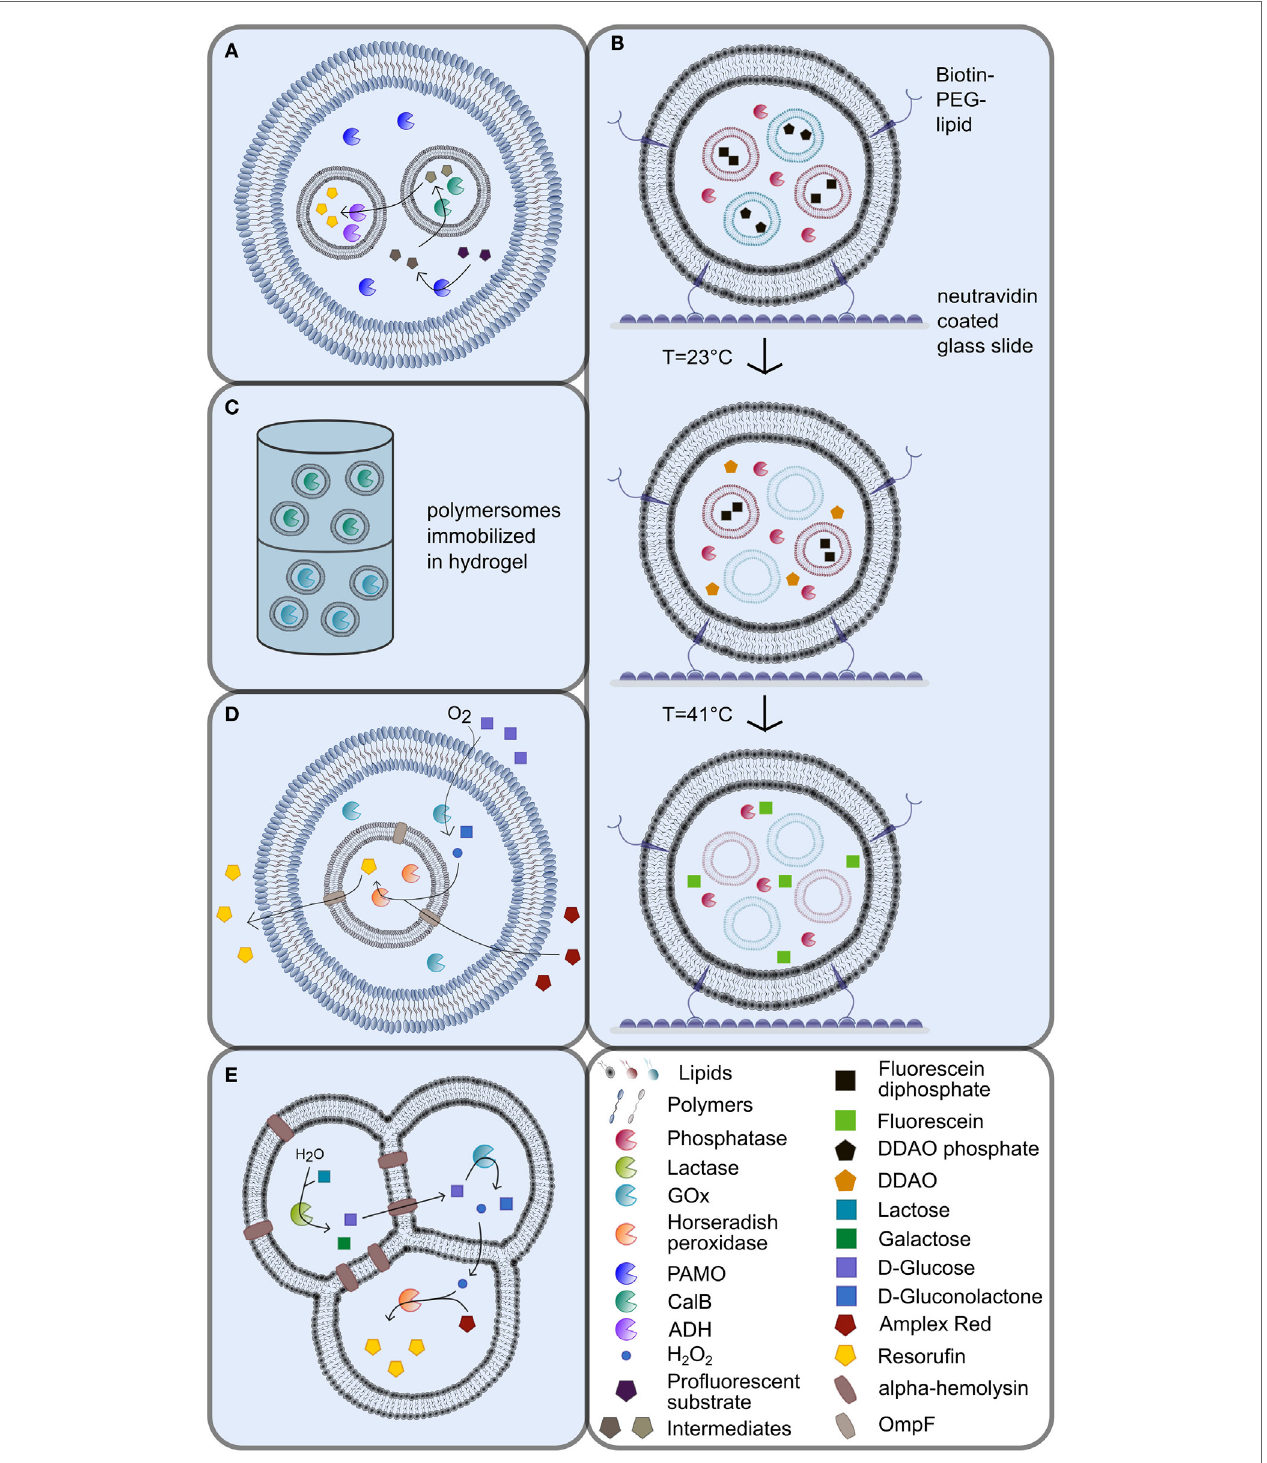
FiGURe 1 | Multicompartmented artificial vesicles as bioreactors . (A) Vesosomes consisting of inner and outer coblock polymersomes with different physicochemical properties [adapted from (Peters et al., 2014)]. (B) Immobilization of biotinylated lipid vesosomes via the interaction with neutravidin in nanofluidic reactors [adapted from (Bolinger et al., 2008)]. The release of liposome contents is triggered by specific, consecutive temperature shifts. (C) Continuous-flow polymersome reactor with immobilized polymersomes in hydrogel (De Hoog et al., 2010). (D) Vesosomes using the porin OmpF as shuttle system [adapted from (Siti et al., 2014)]. (e) Multicompartment liposomes generated by the phase transfer technique [adapted from (Elani et al., 2014)]. For explanations, please refer to the manuscript